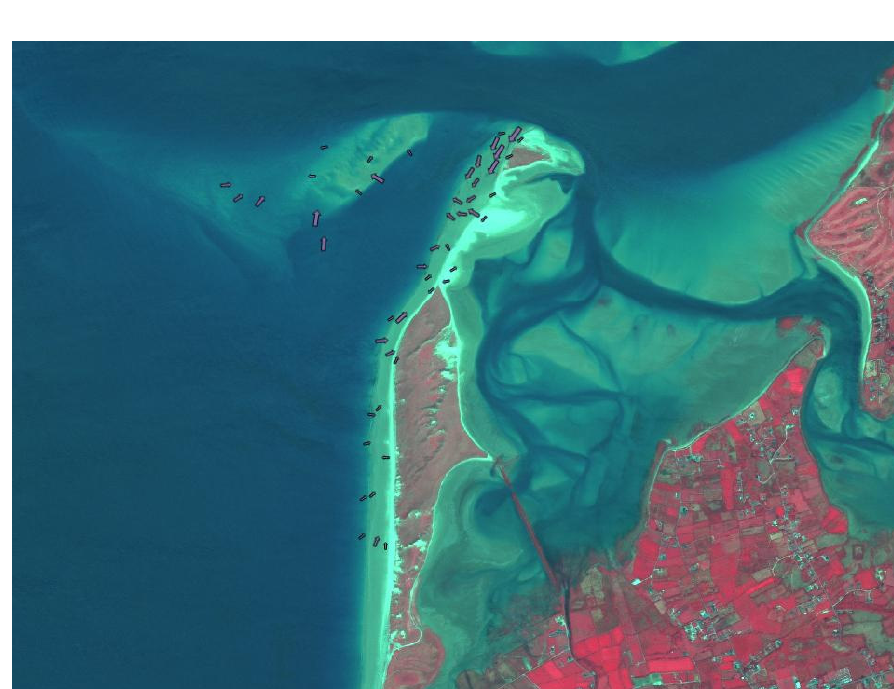
J. Mar. Sci. Eng. 2016 , 4 , 27